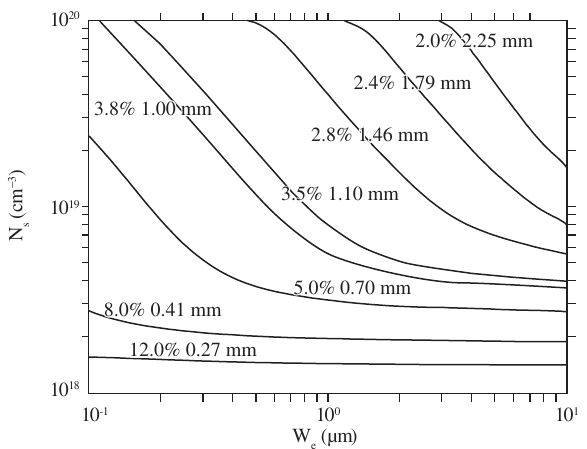
(%) and spacing between fingers, s and thickness, W for s e